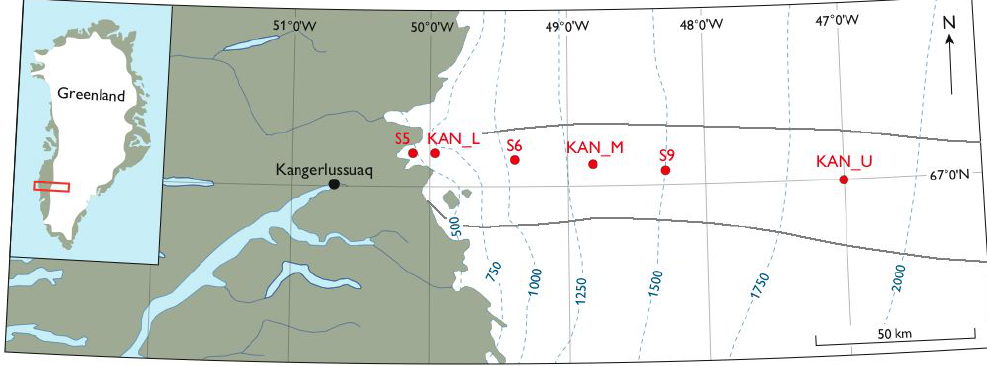
Fig. 1. Map of southwest Greenland including the positions of the automatic weather stations and catchment delineation (grey lines). Table 1. Metadata for the automatic weather stations on the Greenland ice sheet used in this study. Station name Latitude ( ◦ N) Longitude (W) Elevation (m) Date of placement S5 67 ◦ 6 0 50 ◦ 7 0 460 1 Sep 2003 KAN L 67 ◦ 6 0 49 ◦ 56 0 670 1 Sep 2008 S6 67 ◦ 5 0 49 ◦ 23 0 1020 1 Sep 2003 KAN M 67 ◦ 4 0 48 ◦ 49 0 1280 2 Sep 2008 S9 67 ◦ 3 0 48 ◦ 14 0 1510 1 Sep 2003 KAN U 67 ◦ 0 0 47 ◦ 1 0 1830 4 Apr